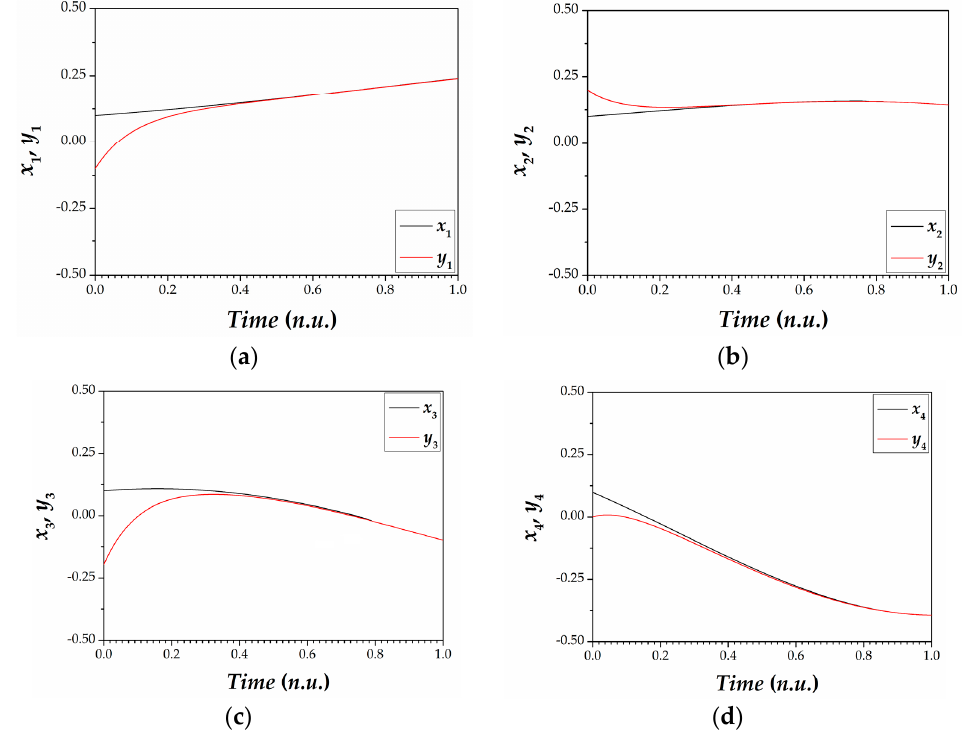
Figure 8. Synchronization of the states ( a ) x 1 ( t ) and y 1 ( t ); ( b ) x 2 ( t ) and y 2 ( t ); ( c ) x 3 ( t ) and y 3 ( t ) and ( d ) x 4 ( t ) and y 4 ( t ).